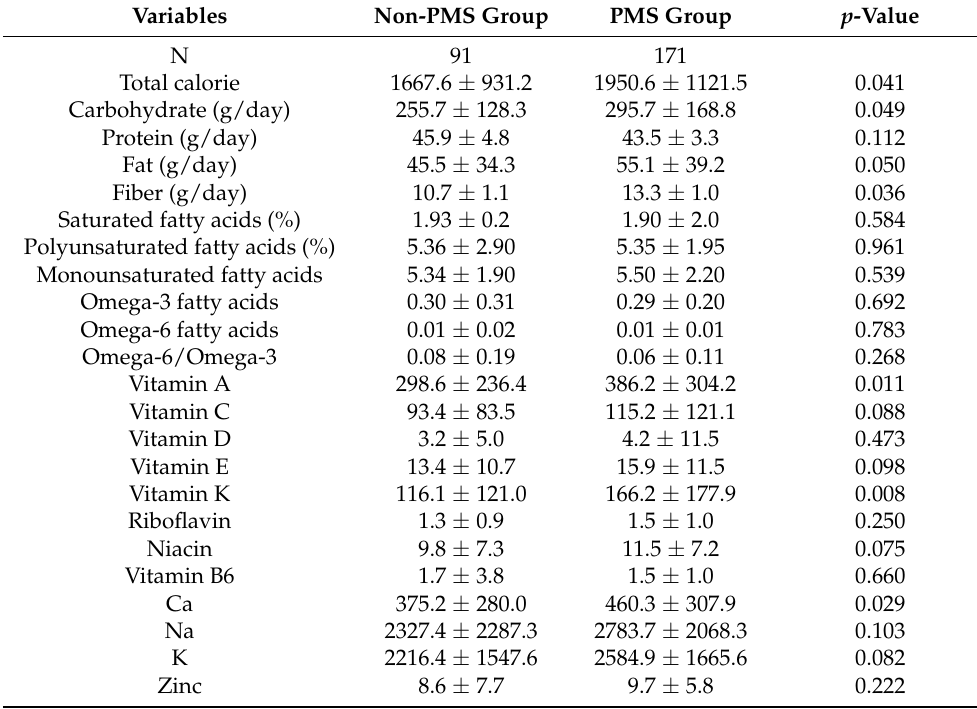
Table 3. Nutritional status by PMS